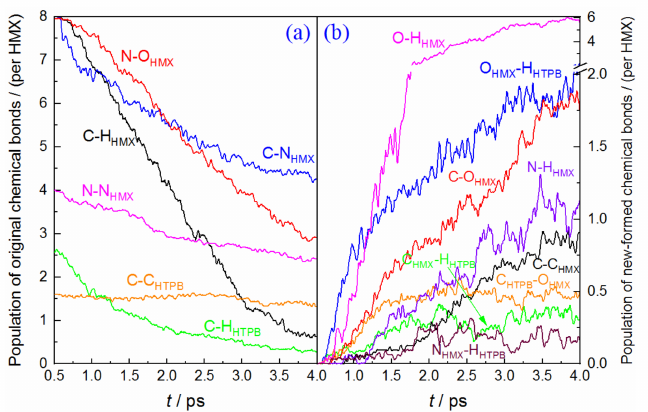
Figure 4. Time dependence of the main chemical bonds involved in HMX(100)/HTPB shock decom- position, ( a ) original chemical bonds, ( b ) new-formed bonds.